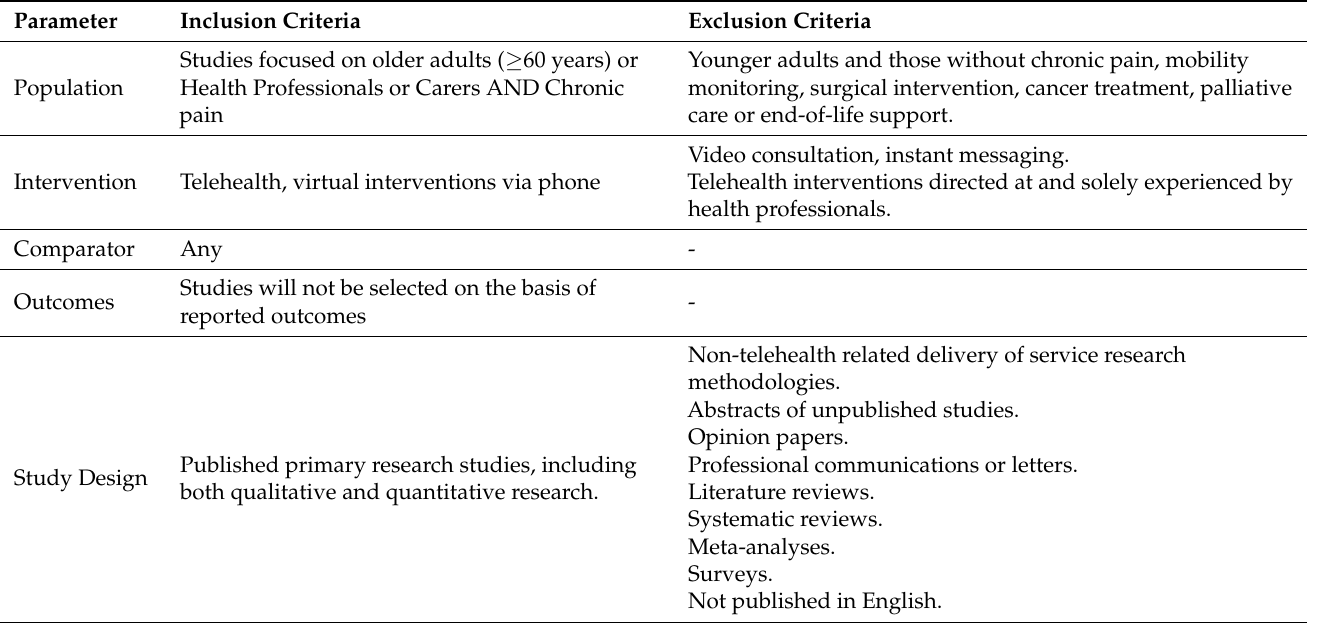
Table 1. Selection